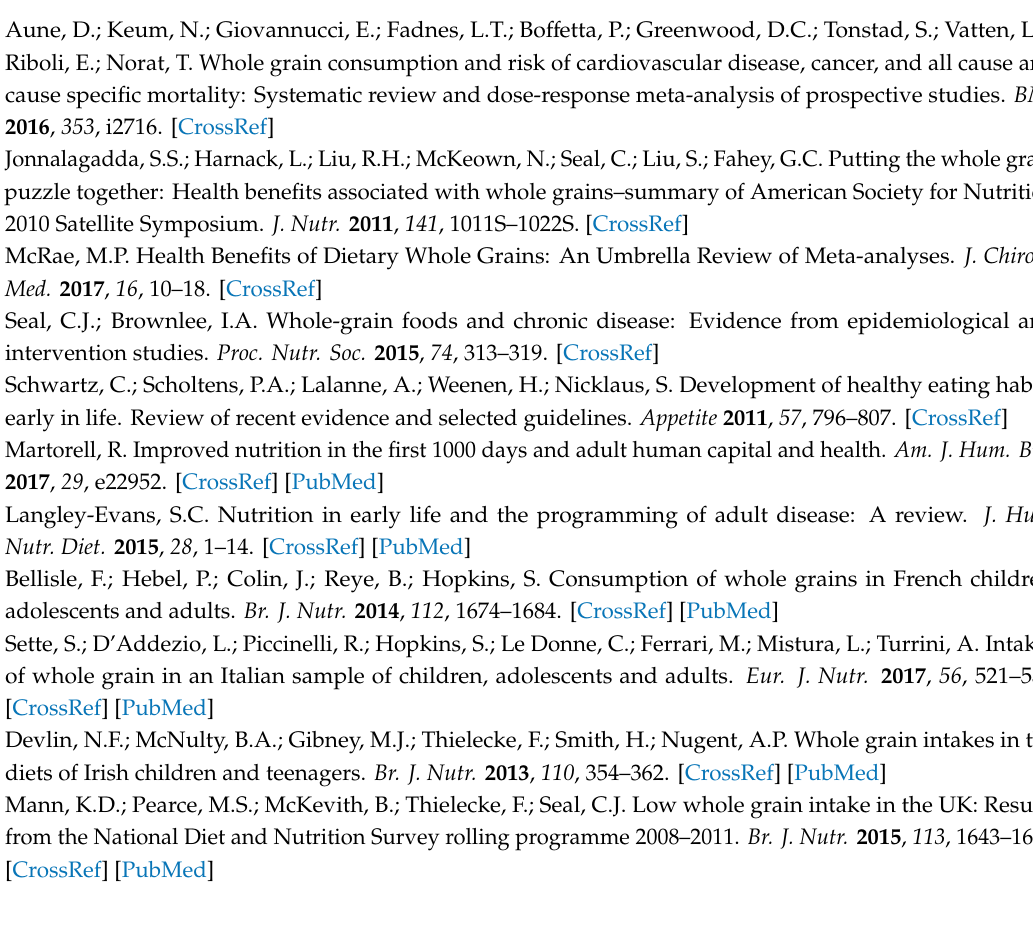
Table S1: Sensitivity analysis: Factors independently a associated with usual wholegrain intakes (unadjusted and adjusted mean values and 95% confidence interval) of children with plausible energy